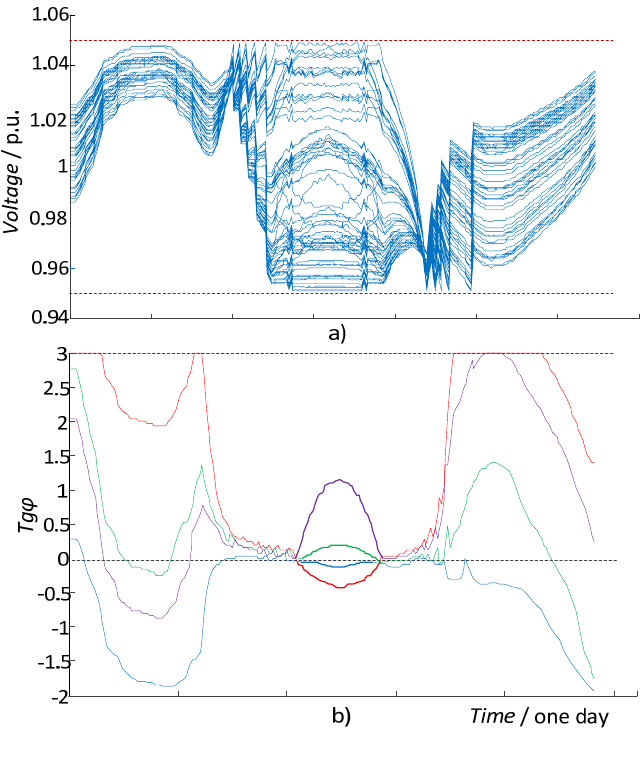
Figure 17. Voltage control to mitigate the voltage rise with a uniform tg φ for every feeder. ( a ) One-day voltage profile of MV/LV substations measured at the critical areas around the distribution system; ( b ) optimal tg φ for four different feeders. As the penetration of DG around the twelfth hour is very high, tg φ has to withdraw its optimal daily